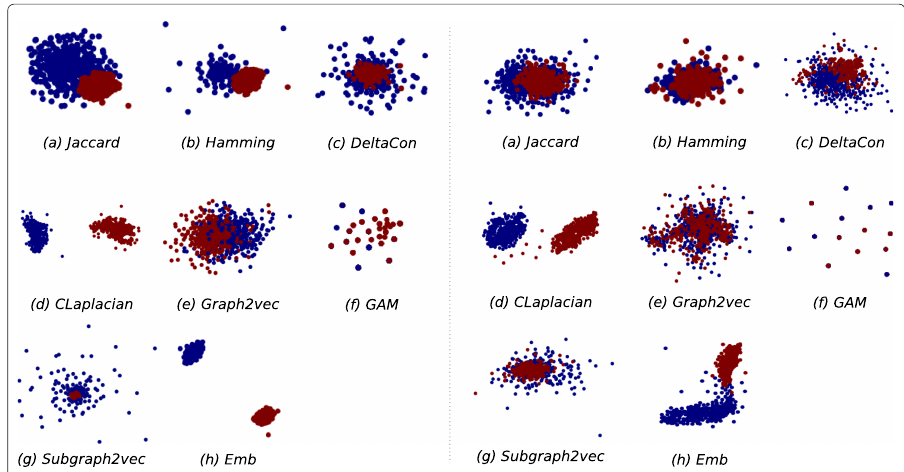
Fig.4 (Left) networks from Mixed dataset.Blue color correspond to ER networks and red color are BA networks, both groups with (cid:11) d (cid:12) = 6. (Right) Networks generated with the LFR benchmark. Blue color correspond to networks with well defined communities, μ = 0.1 whereas red color are networks generated with μ =